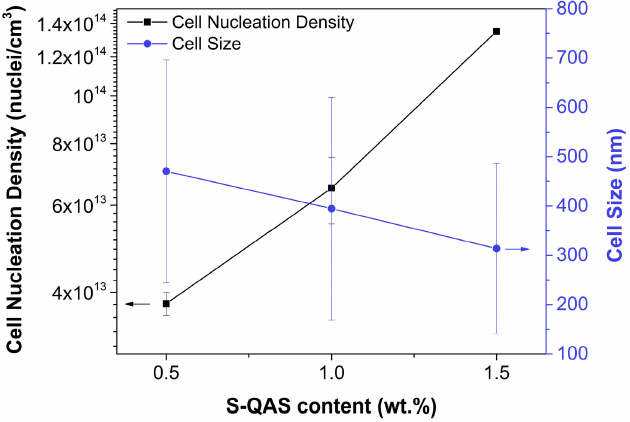
Figure 5. Cell nucleation density (left axis) and cell size (right axis) as a function of the sepiolite quaternary salt (S-QAS) content in the PMMA/sepiolites